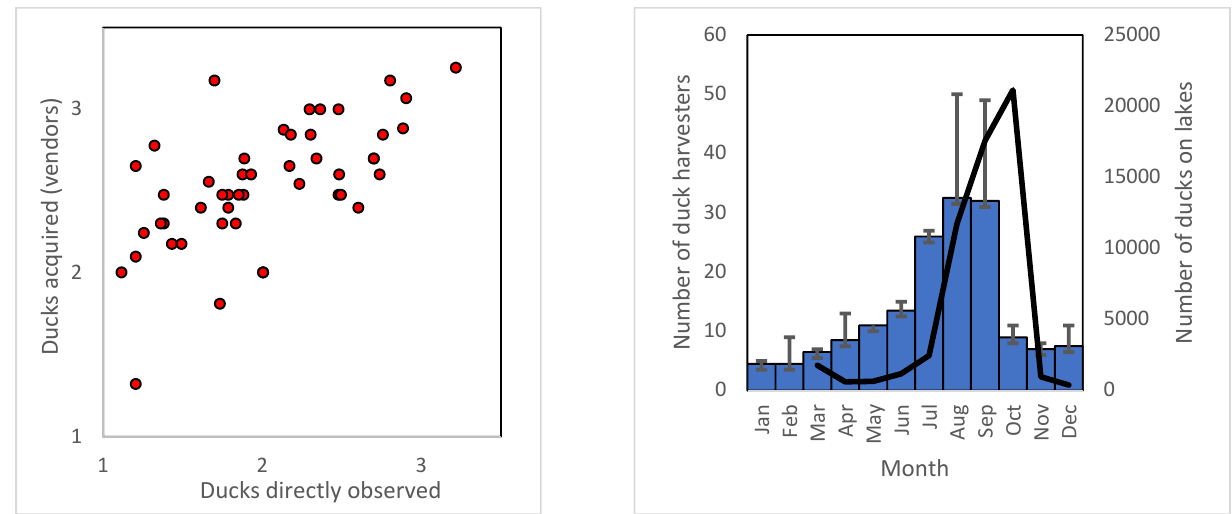
Figure 1. Illegal harvest and trade in wandering whistling duck Dendrocygna arcuata (June 2005 to April 2007). Left: Data from 23 monthly surveys of the premises of wholesale traders in East Kalimantan and from verbal reports of the number of ducks traded (both expressed on logarithmic scales) showing high levels of agreement. Right: Number of duck harvesters active in each month on Lake Jempang, Lake Semayang, and Lake Melintang (Mean + SEM) (bars) and the number of wandering whistling duck observed on these lakes during surveys (continuous line).